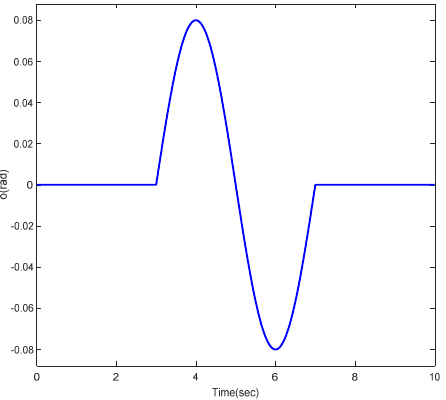
Figure 5. Front wheel steering angle under SLC maneuver.